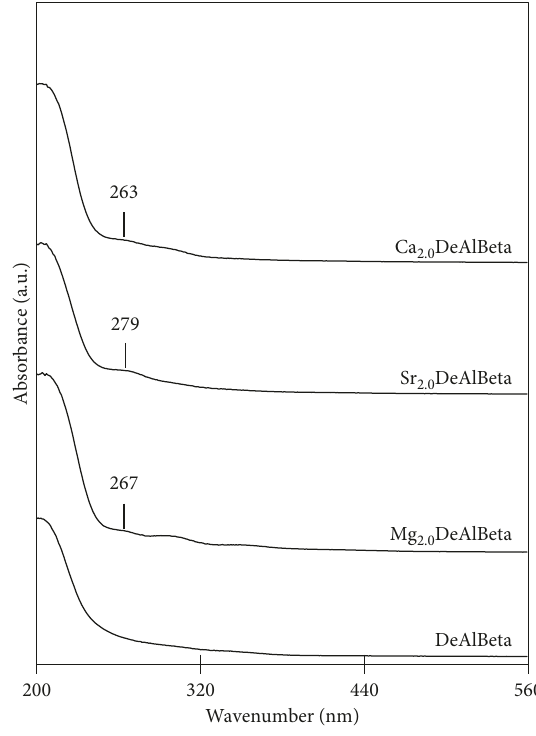
Figure 7: DR UV-vis spectra recorded at room temperature and ambient atmosphere for DeAlBeta, Mg 2.0 DeAlBeta, Sr 2.0 DeAlBeta, and Ca 2.0 DeAlBeta samples.